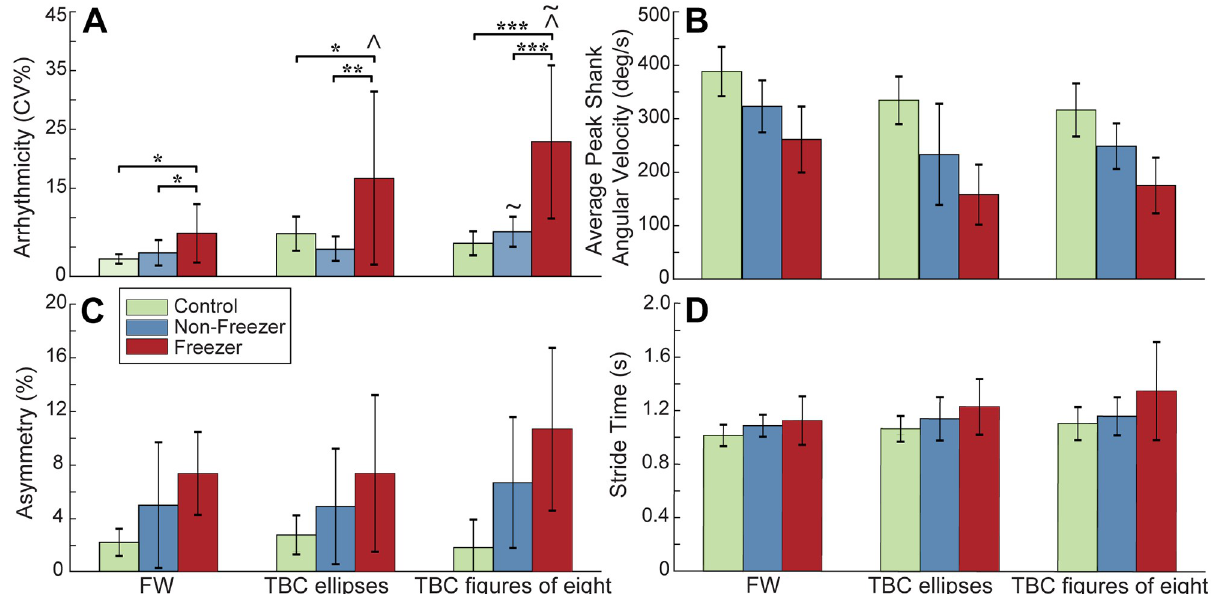
Fig 4. Group gait parameters during walking tasks. A: Gait arrhythmicity, B: average peak shank angular velocity, C: asymmetry, and D: stride time in healthy controls, non-freezers and freezers, during non-freezing FW, TBC ellipses and TBC figures of eight. Error bars represent standard deviation. � p < 0.05; �� p < 0.01; ��� p < 0.001; ^ p < 0.05 TBC ellipses and TBC figures of eight compared to FW in freezers; ~ p < 0.05 between TBC ellipses and TBC figures of eight in non-freezers and in freezers.